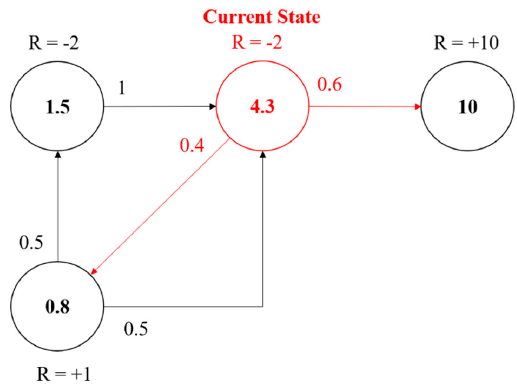
Figure 6. Example of the calculation of value function.